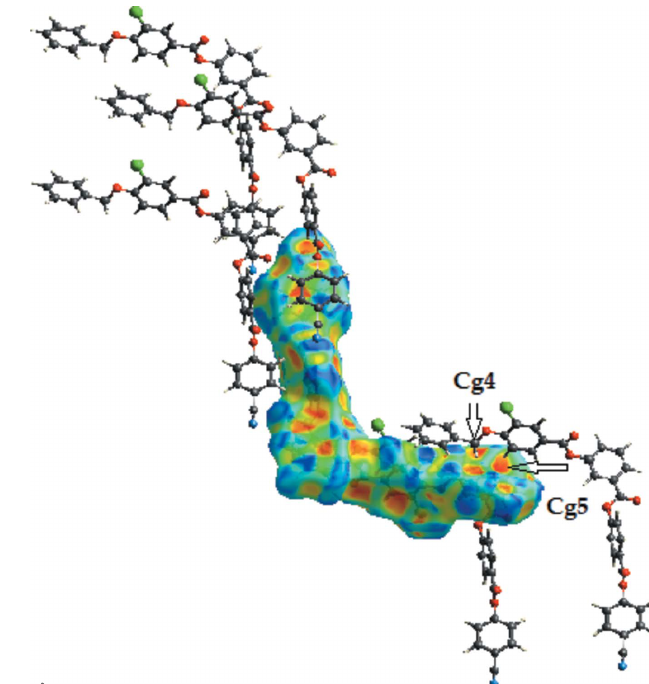
Figure 7 Hirshfeld surface of the title compound mapped over shape-index, showing the C—H (cid:3)(cid:3)(cid:3) (cid:2)